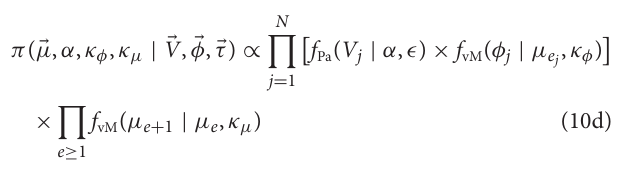
FIGURE 11 | Epoch-specific posterior predictive density functions for PDC initial directions the top left of each subplot) for the azimuth range of the valley actually inundated by the next major ( V j > (cid:127) ) PDC at epoch-ending time T e displayed centered at 0 ◦ , due East.